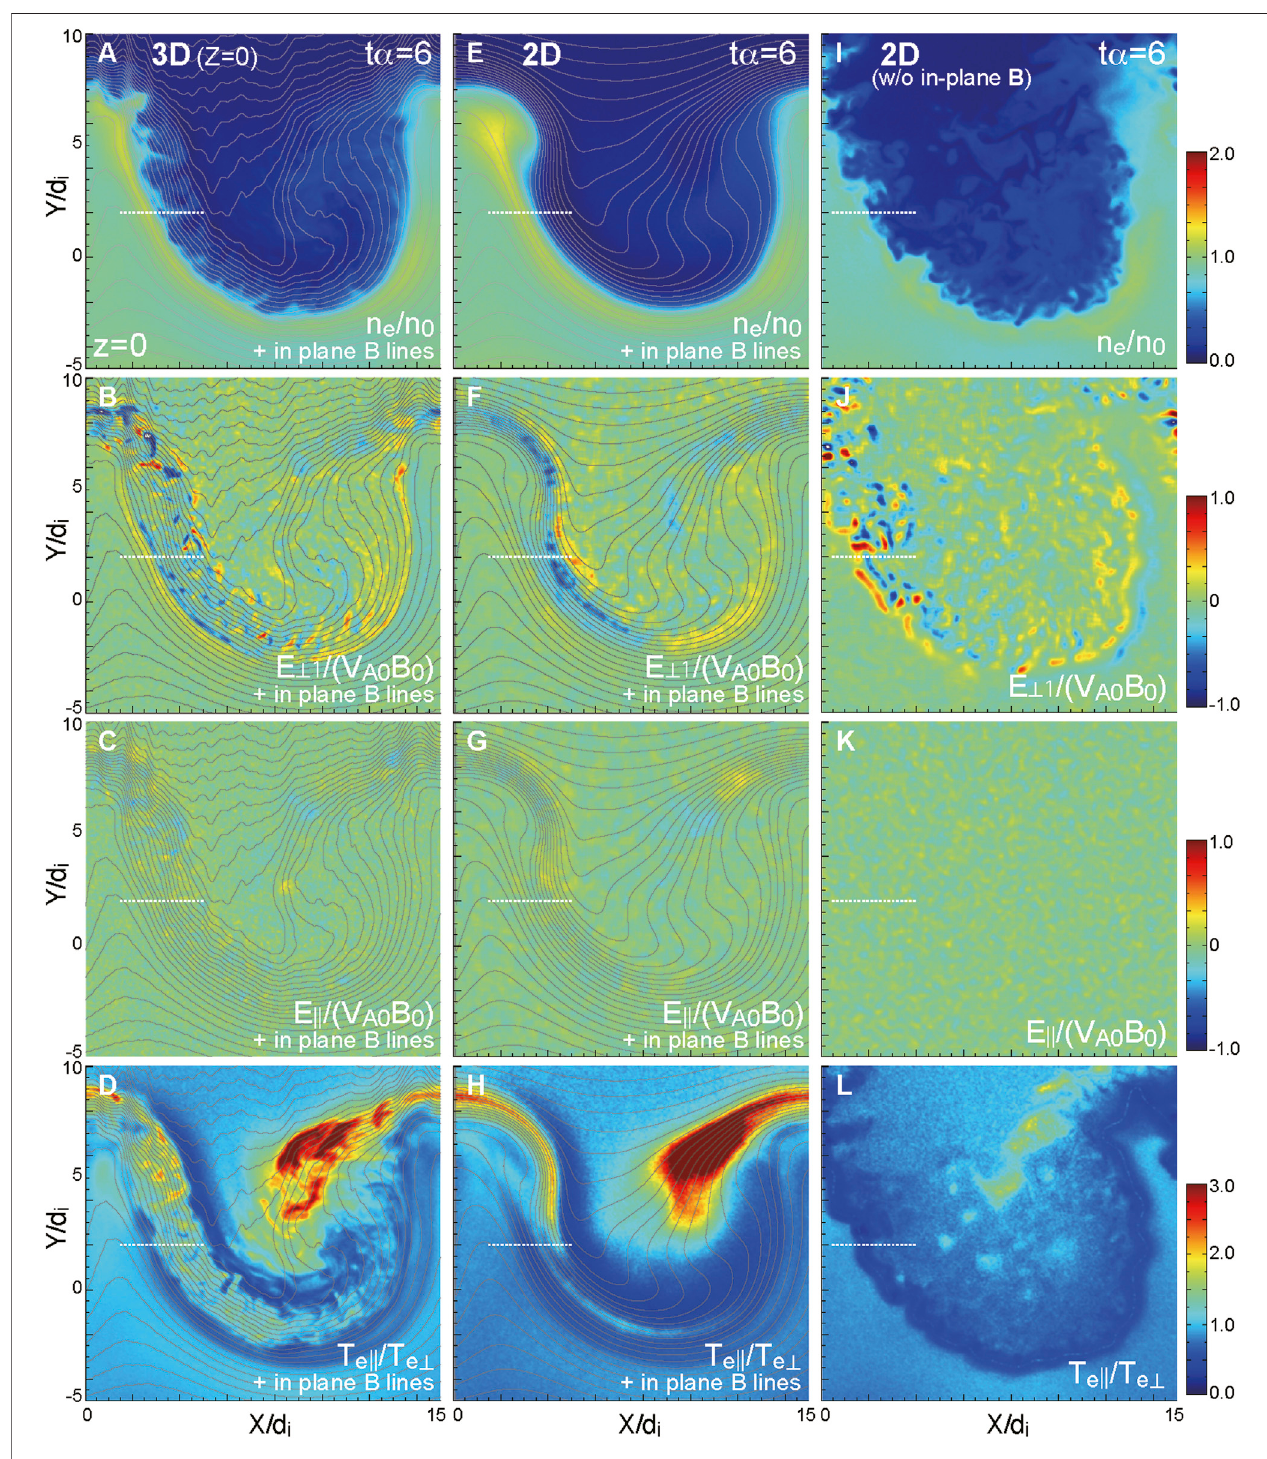
FIGURE 2 | Color contours in the x-y plane ( z (cid:1) 0 for the 3-D run) of n e , the perpendicular and parallel components of E , and the ratio of the parallel and perpendicularelectron temperatures T e (cid:3) / T e ⊥ at t (cid:1) 6 α − 1 forthe3-D (A – D) ,thecorresponding2-D (E – H) ,and2-Dwithoutinitialin-plane fi elds (I – L) runs.Thegraycurves for the 3-D and corresponding 2-D runs show the surfaces of the z-component of the vector potential.